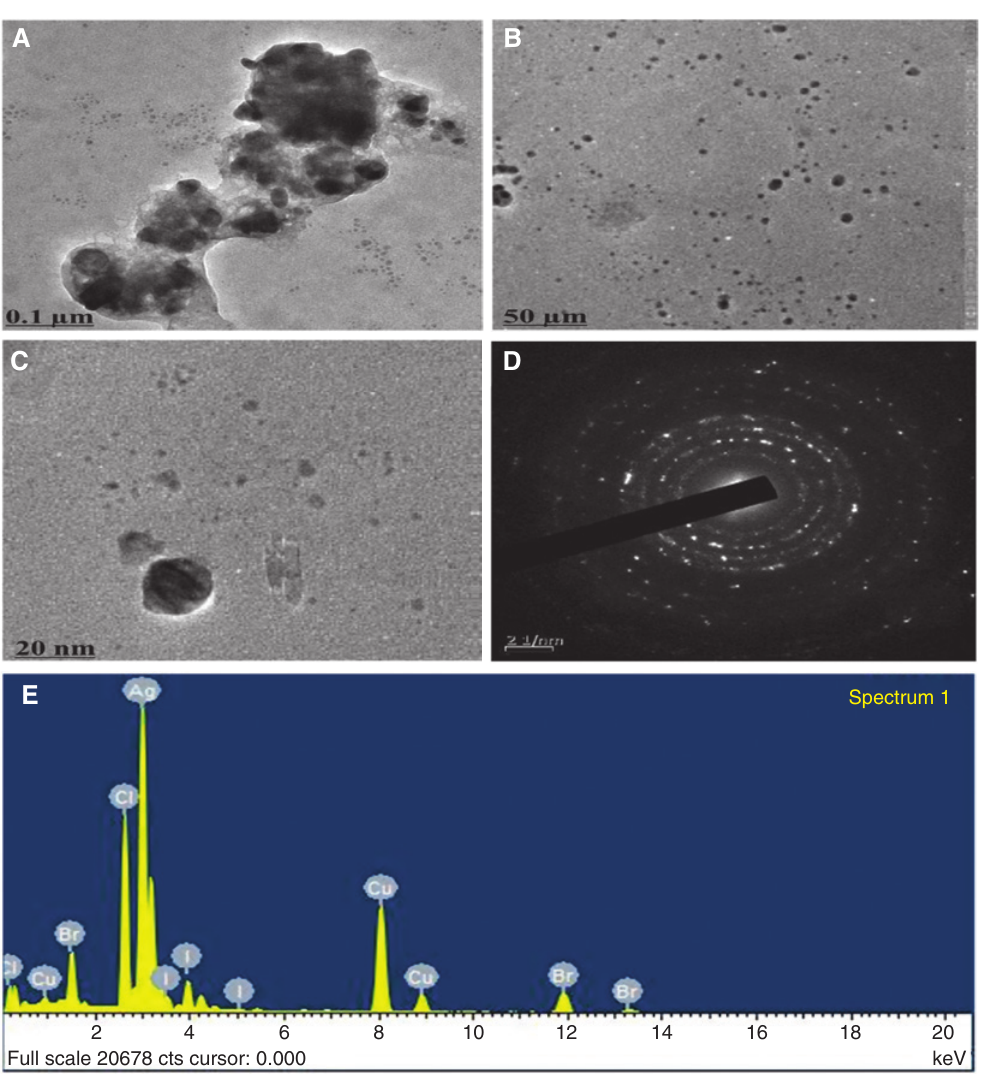
Figure 5: HR-TEM images: (A) 0.1 μ m scale, (B) 50 nm scale, (C) 20 nm scale, (D) selected area diffraction pattern, and (E) EDX analysis of optimized (1 mm AgNO , 40 ° C, and 45 min) AgNPs synthesized by DSP extract. 3